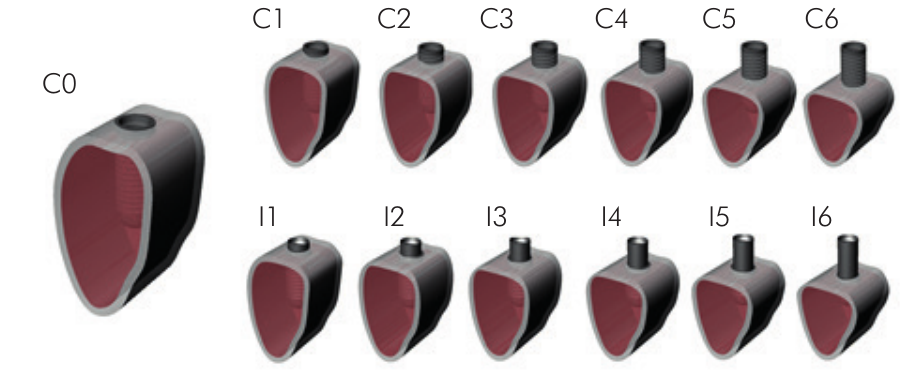
Figure 2. Group distribution according to exposed implant and presence of implantoplasty: C0) Control Group; C1) 1 mm of